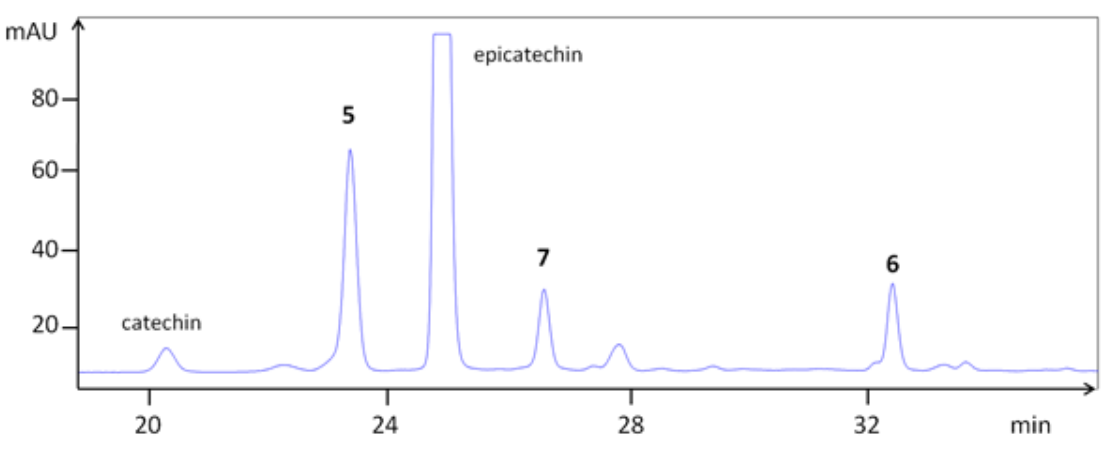
Figure 4. HPLC chromatogram of a bark extract of Aronia melanocarpa showing procyanidins B2 ( 5 ), B5 ( 6 ) and C1 ( 7 ).